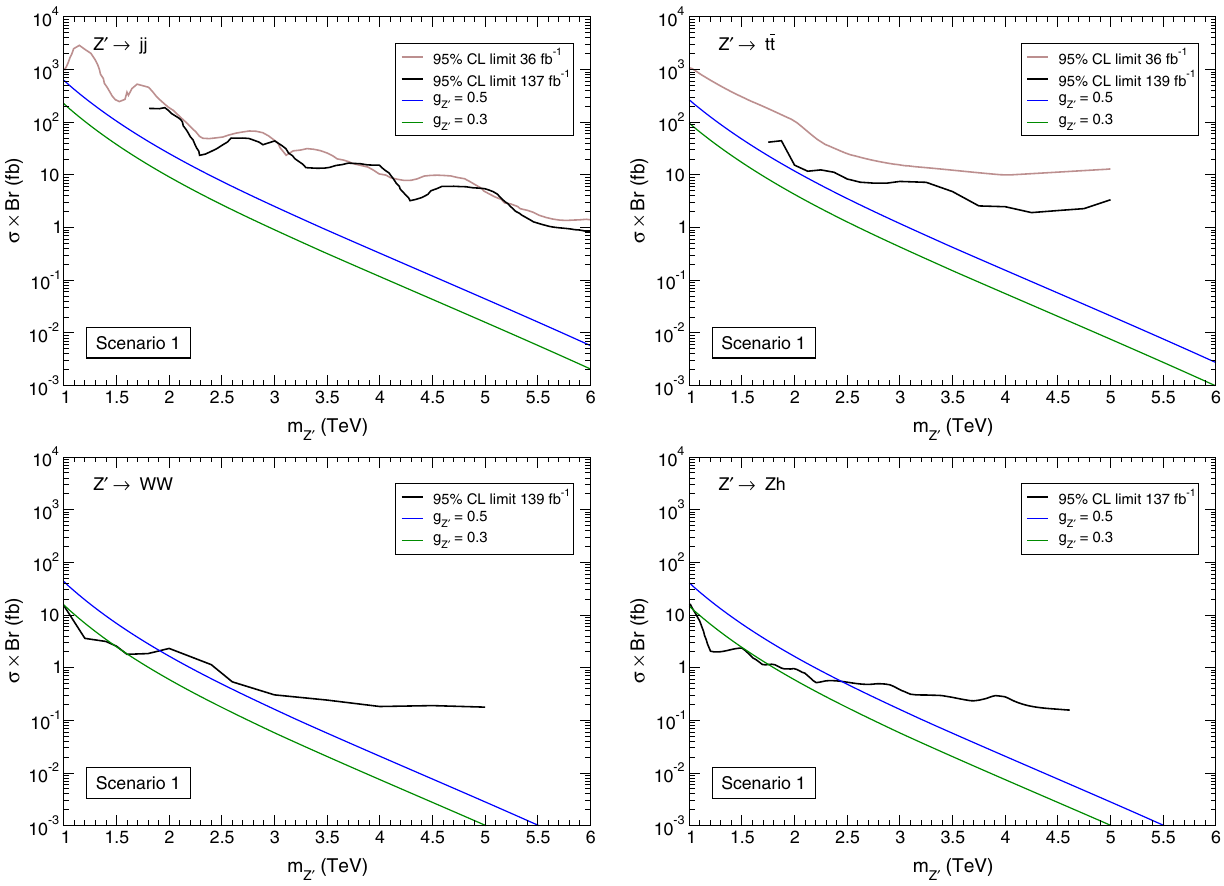
Fig. 2 Limits on the cross section times branching ratio for the production of Z (cid:2) bosons arising from searches in several final states: dijets [22,23] (top left), t ¯ t [24,25] (top right), WW [3] (bottom left) and Zh [4] (bottom right). Together, we show two cross section predictions for g Z (cid:2) = 0 . 3 , 0 . 5